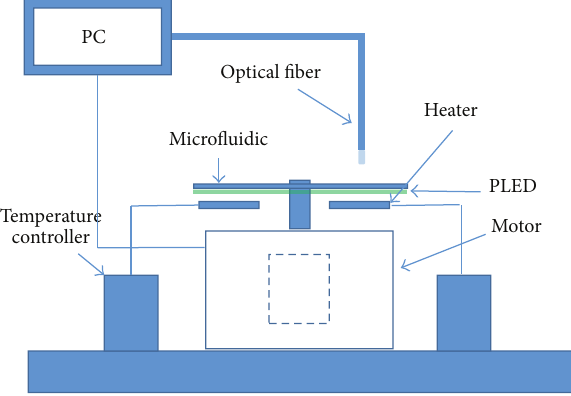
Figure 3: Experimental setup for CD microfluidic testing.